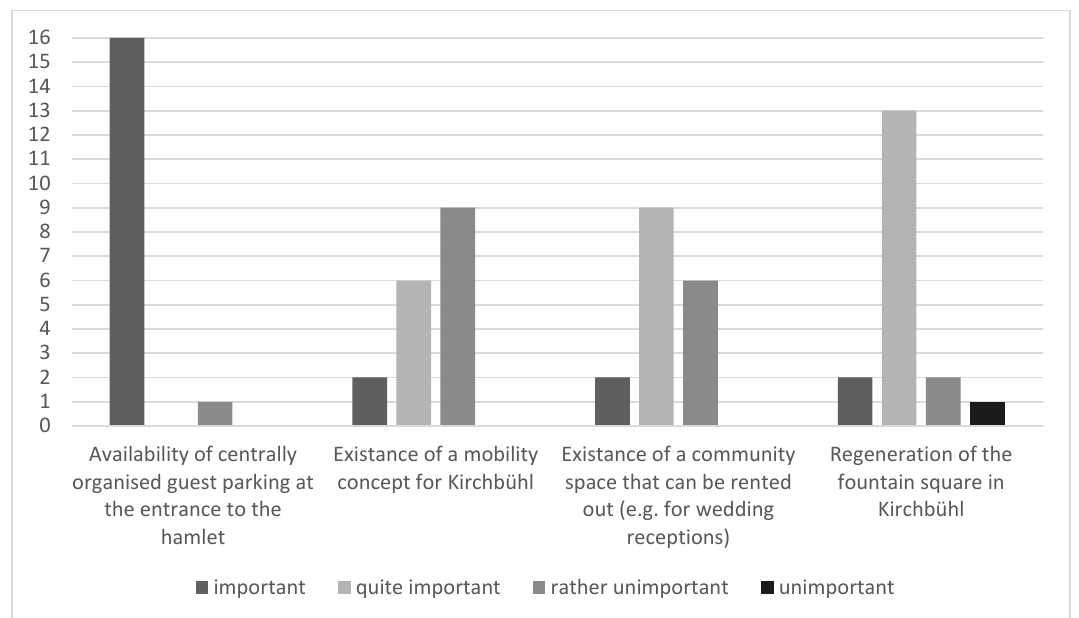
Figure 21: Results on the importance of different development